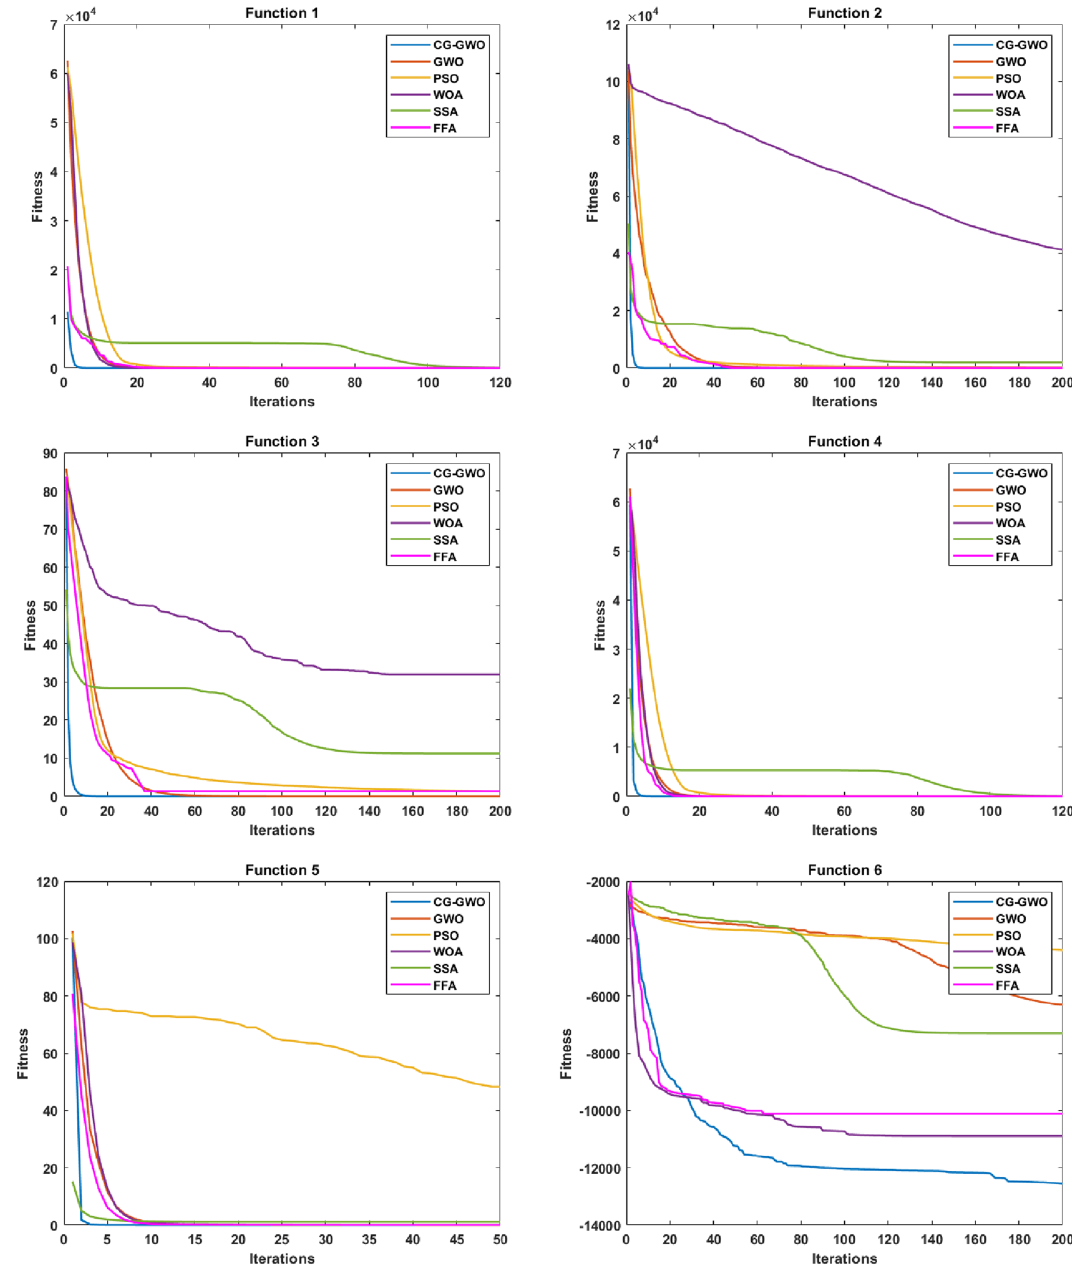
Figure 5. Convergence curve comparison of classic optimization